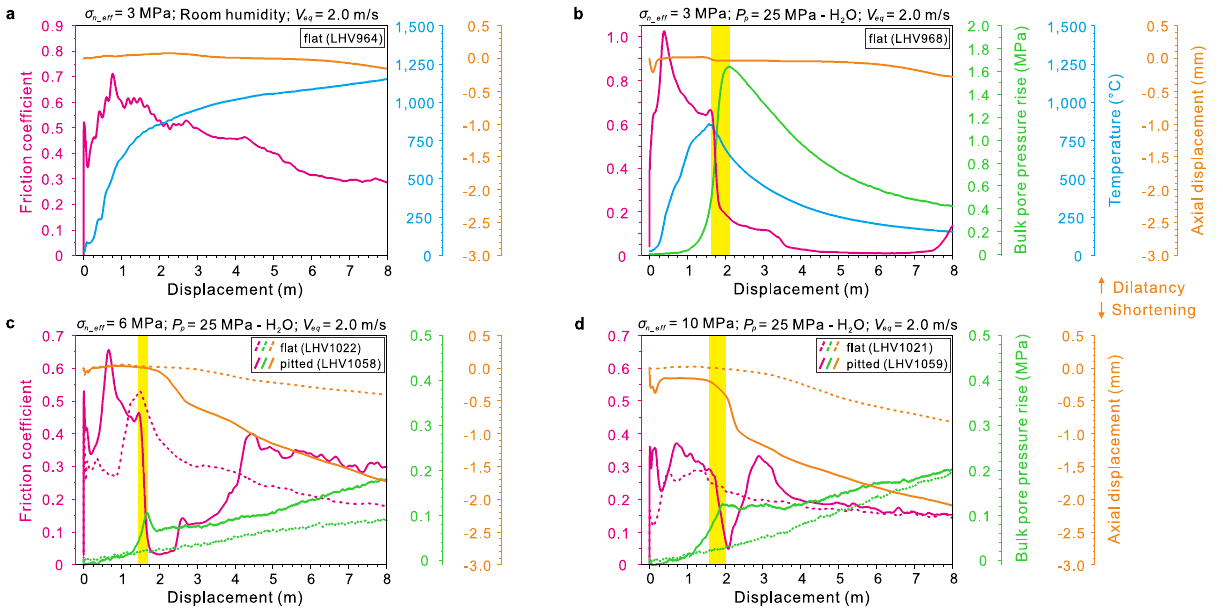
Fig. 2 | Experimental results. Evolution of friction coef fi cient, bulk pore pressure rise, temperatureand axial displacement with slip displacement from experiments conducted under effective normal stress σ n_ eff =3 – 10MPa, slip rate V eq =2.0m/s, androomhumidity( a )orporewaterpressure P p of25MPa( b – d ).Twokindsofslip